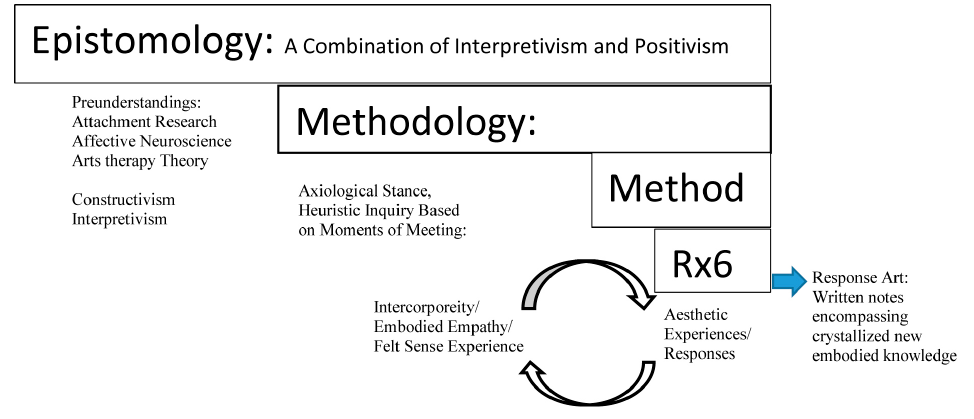
FFigigururee 1.1. TheThe inquiryinquiry frfromom epistepistemolemologyogy ttoo methodolmethodologyogy andand methodmethod (Ger(Gerggee,,